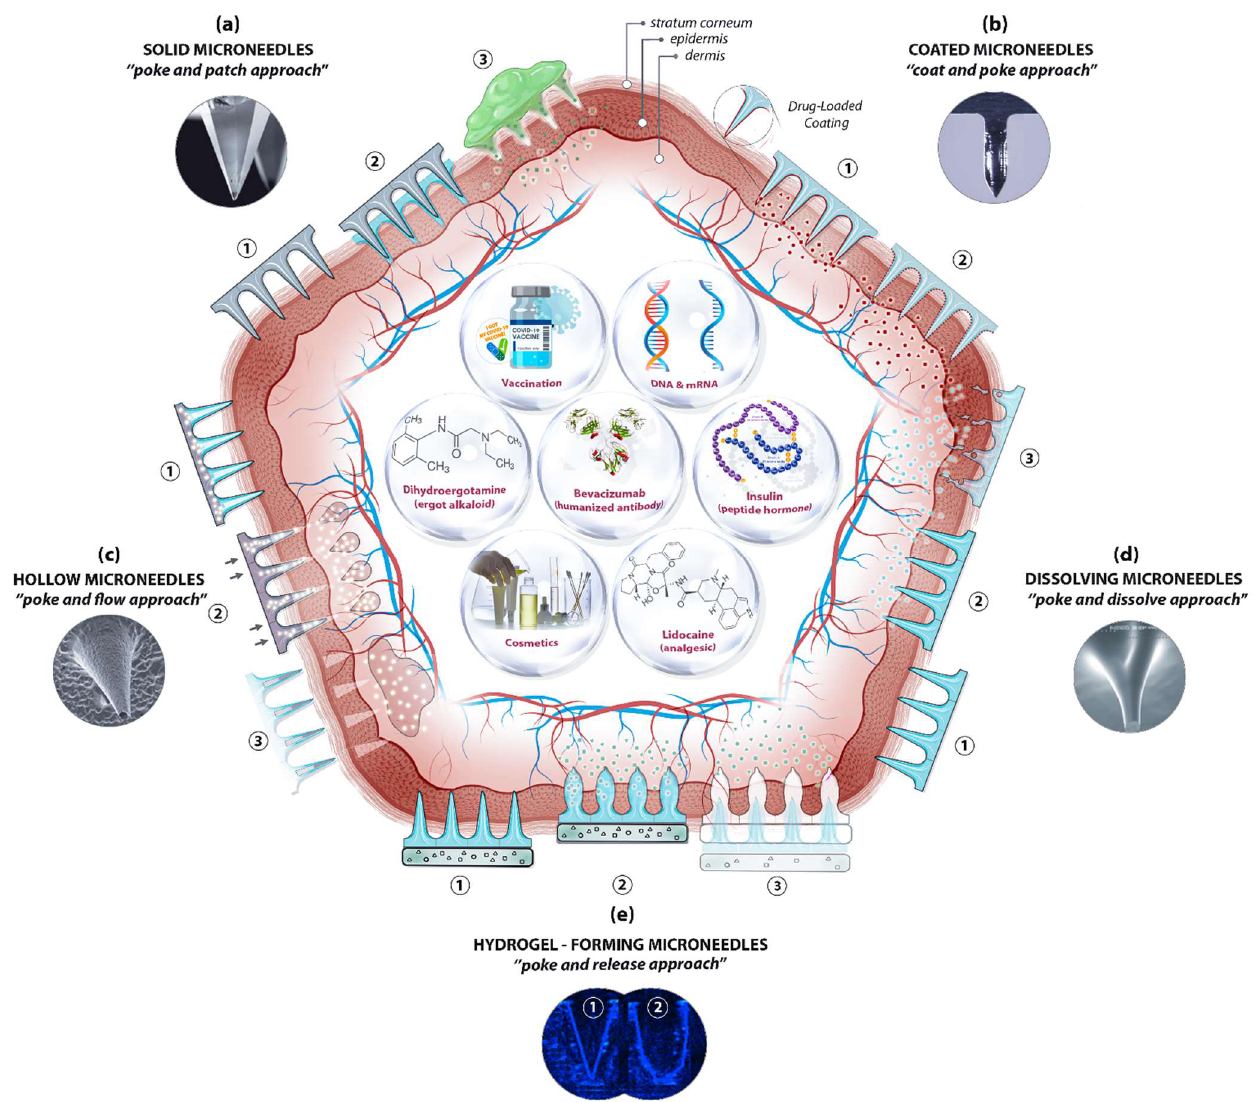
Figure 2. A schematic diagram of microneedle (MN)-based drug delivery approaches with the cross section of the upper layer of the skin. The approaches are ( a ) solid MNs, ( b ) coated MNs, ( c ) hollow MNs, ( d ) dissolving MNs, and ( e ) hydrogel- forming MNs. The step-by-step process of each delivery approach is numbered from 1 to 3. Representative microscopic images of MN types and examples of deliverable payloads such as drugs and bio-macromolecules are also shown. Images was adopted with permission from [42,43]).